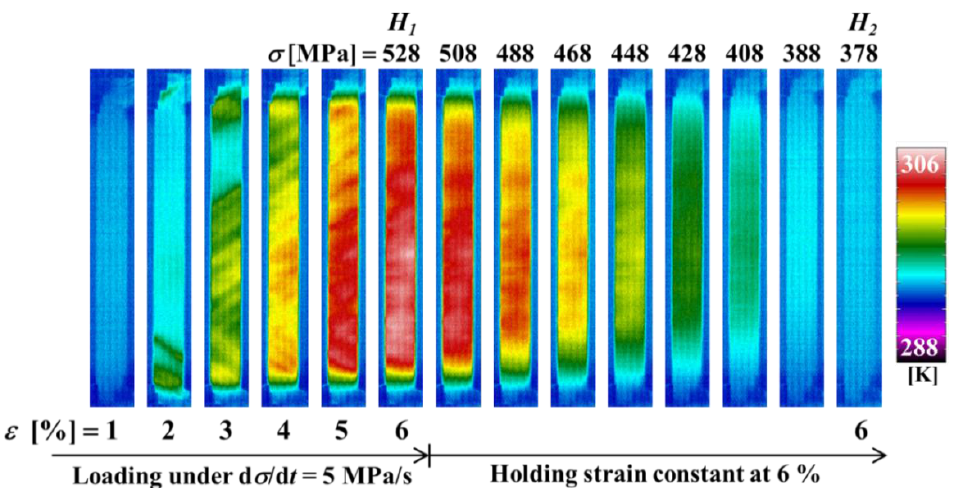
Figure 6. Thermograms of temperature distribution on the specimen surface at various strains ε during loading under a stress rate of 5 MPa/s until a point H various stresses σ while holding the strain constant at 6% until point H